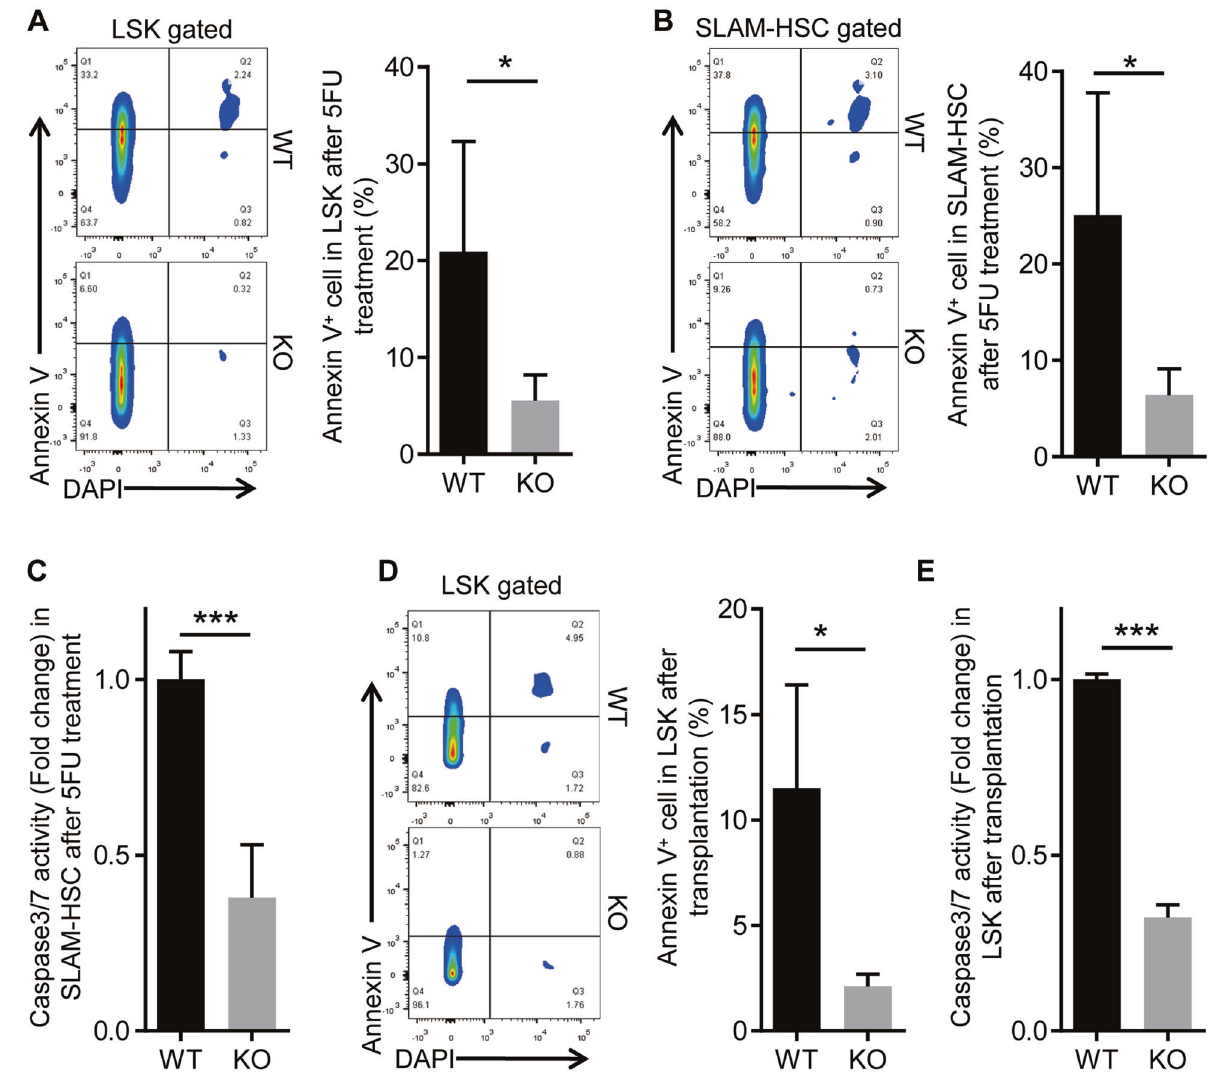
14 days. Representative FACS plots (left) and bar graph (right) depict the percentage of Annexin V positive cells in donor-derived LSK cells ( n = 5). E Caspase 3/7 activity of the LSK cells as in ( D ) ( n = 3). Data are presented as mean ± SD, (* p < 0.05, and *** p <